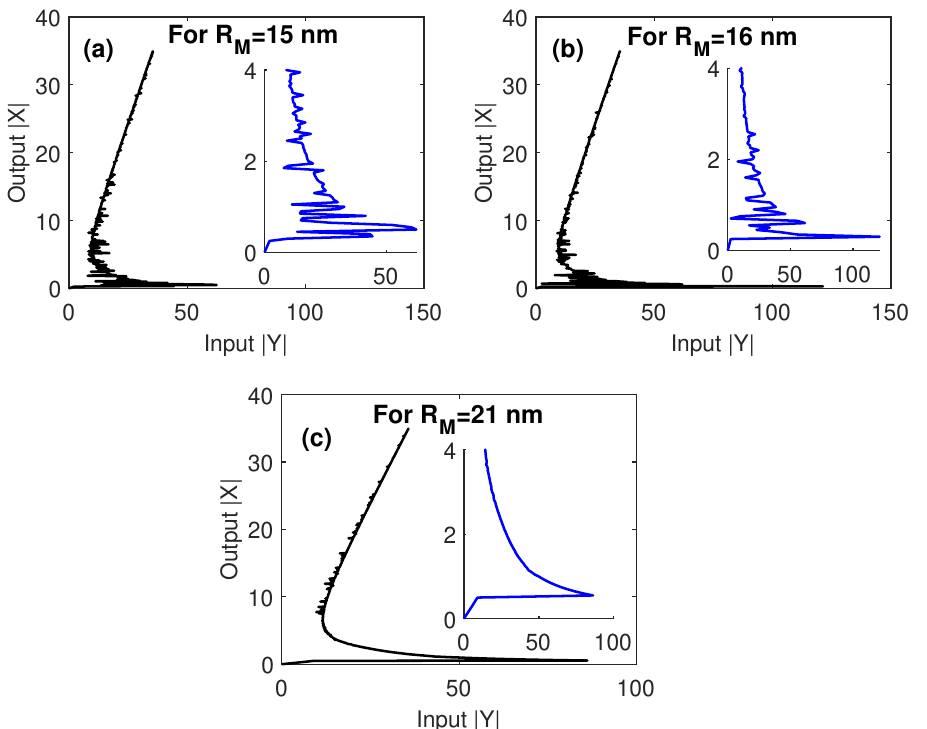
Figure 4. The output versus the input for different values of the MNP size, under EIT conditions; Ω = 2, and γ 32 = 0.4. The other parameters were c γ 12 γ 12 rad and C = 121.36, and the mobility of GND was µ = 10 4 cm 2